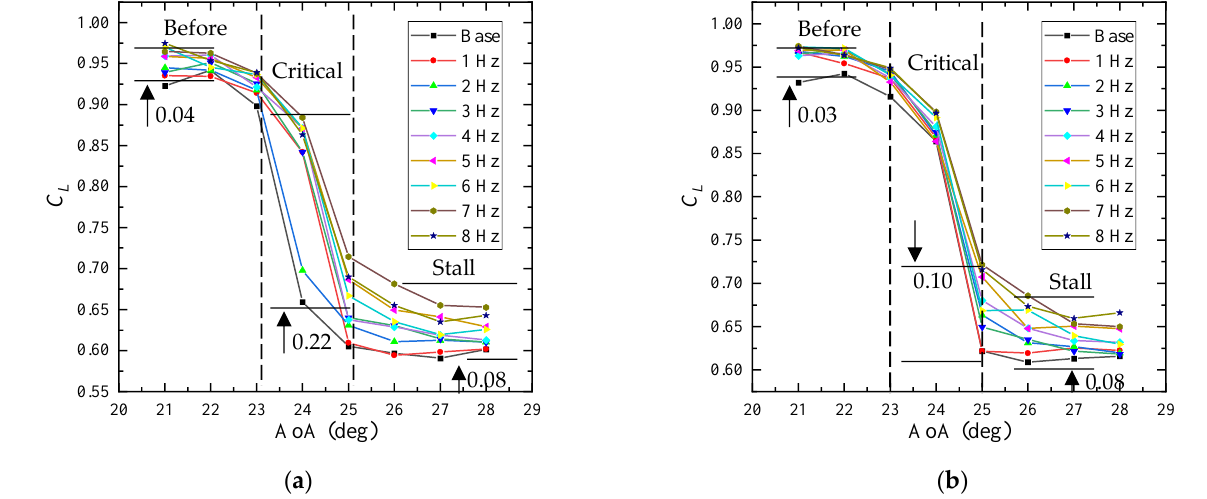
Figure 29. Lift coefficient of mTE4 at different trailing edge vibration frequencies and amplitudes (airspeed 10 m/s). ( a ) Vibration amplitude of 4°. ( b ) Vibration amplitude of 6°.